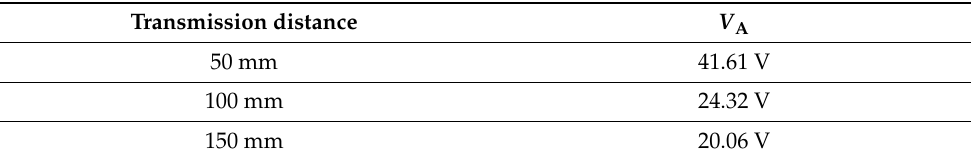
Table 3. V A at different transmission distances.